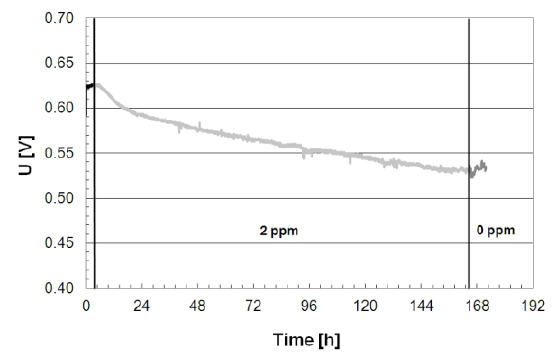
Figure 3. The effect of 2 ppm H